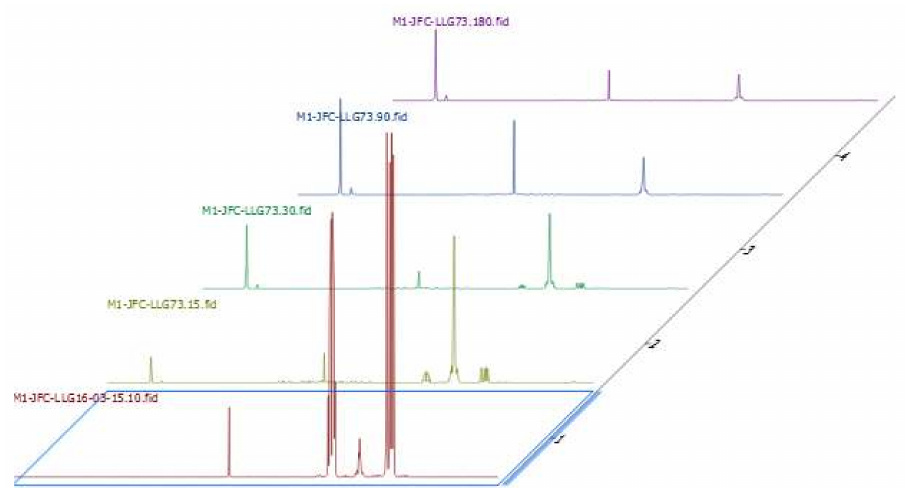
Figure A2. 1 H NMR (400 MHz, CDCl 3 , 298 K) monitoring of a reaction mixture over time during an isomerization phenomenon in CH 3 CN with the Rh-calixarene-bisphosphite ( L2 ) catalyst system (conditions: 1 / 1- int -x (93.5:6.5) = 3.15 mmol, [ 1 ] 0 = 0.4 M, [ 1 ] 0 /[Rh] = 3000, [ L2 ] 0 /[Rh] = 20, P = 20 bar